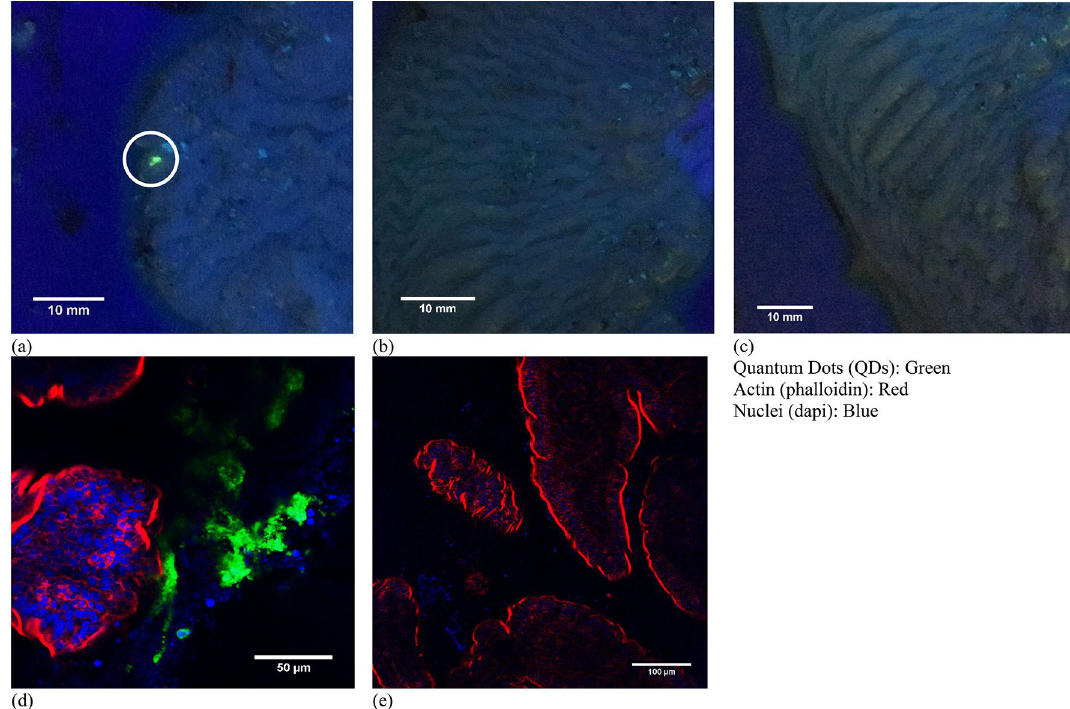
Figure 4. ( a – c ) Tissue from animal 20170921-P1. ( a ) Tissue sections exposed to insonation and QDs (white circle). ( b ) Tissue from area exposed to insonation only (no QDs). ( c ) Tissue from area exposed to QDs only. ( d , e ) Immunofluorescent staining of samples ( a , c ). The QDs were never detected inside epithelial cells marked by F-actin (red), which is highly concentrated in the apical brush border. Images a, b and c are reproduced with permission from 28